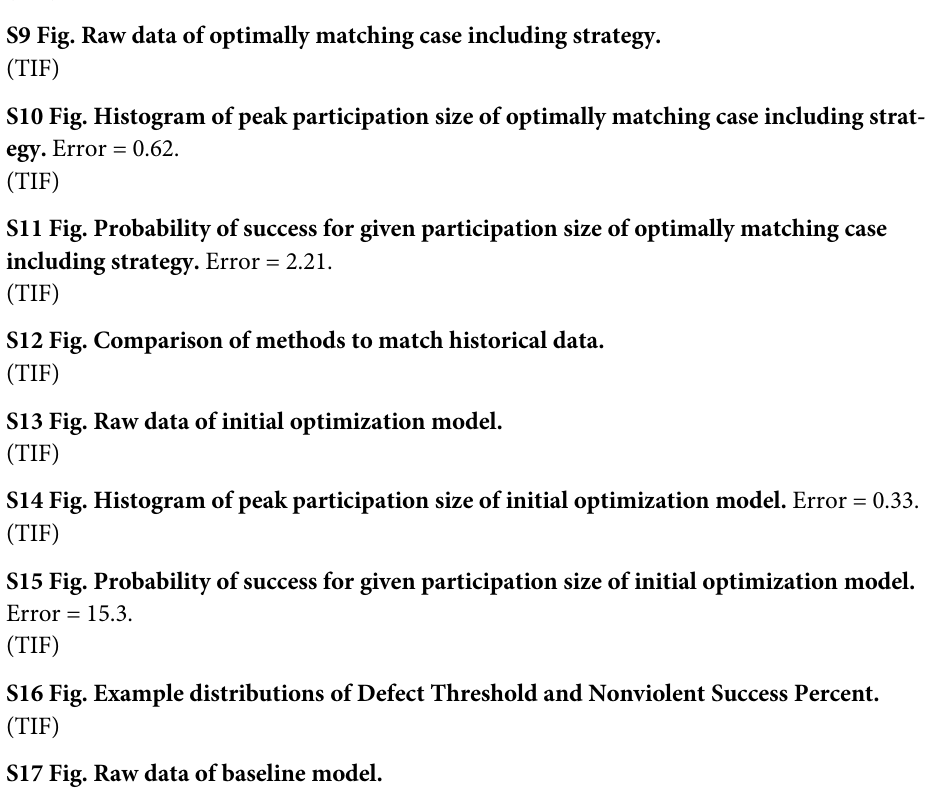
(TIF) S8 Fig. Probability of success for given participation size for three runs of baseline case. Error = 9.48, 13.0, and 8.7 respectively. (TIF) S9 Fig. Raw data of optimally matching case including strategy. (TIF) S10 Fig. Histogram of peak participation size of optimally matching case including strat- egy. Error = 0.62. (TIF) S11 Fig. Probability of success for given participation size of optimally matching case including strategy. Error = 2.21. (TIF) S12 Fig. Comparison of methods to match historical data. (TIF) S13 Fig. Raw data of initial optimization model. (TIF) S14 Fig. Histogram of peak participation size of initial optimization model. Error = 0.33. (TIF) S15 Fig. Probability of success for given participation size of initial optimization model. Error = 15.3. (TIF) S16 Fig. Example distributions of Defect Threshold and Nonviolent Success Percent. (TIF) S17 Fig. Raw data of baseline model. (TIF) S18 Fig. Histogram of peak participation size of baseline model. Error = 0.50. (TIF) S19 Fig. Probability of success for given participation size of baseline model. Error = 9.37. (TIF) S20 Fig. Overall probability of success for each defect threshold value. (TIF) S21 Fig. Probability of success at a given peak participation. (TIF) S22 Fig. Overall probability of success for each defect threshold value. (TIF) S23 Fig. Probability of success at a given peak participation. (TIF) S24 Fig. Probability of success for given participation size with 50% of runs using Pillar Prox strategy = 1.